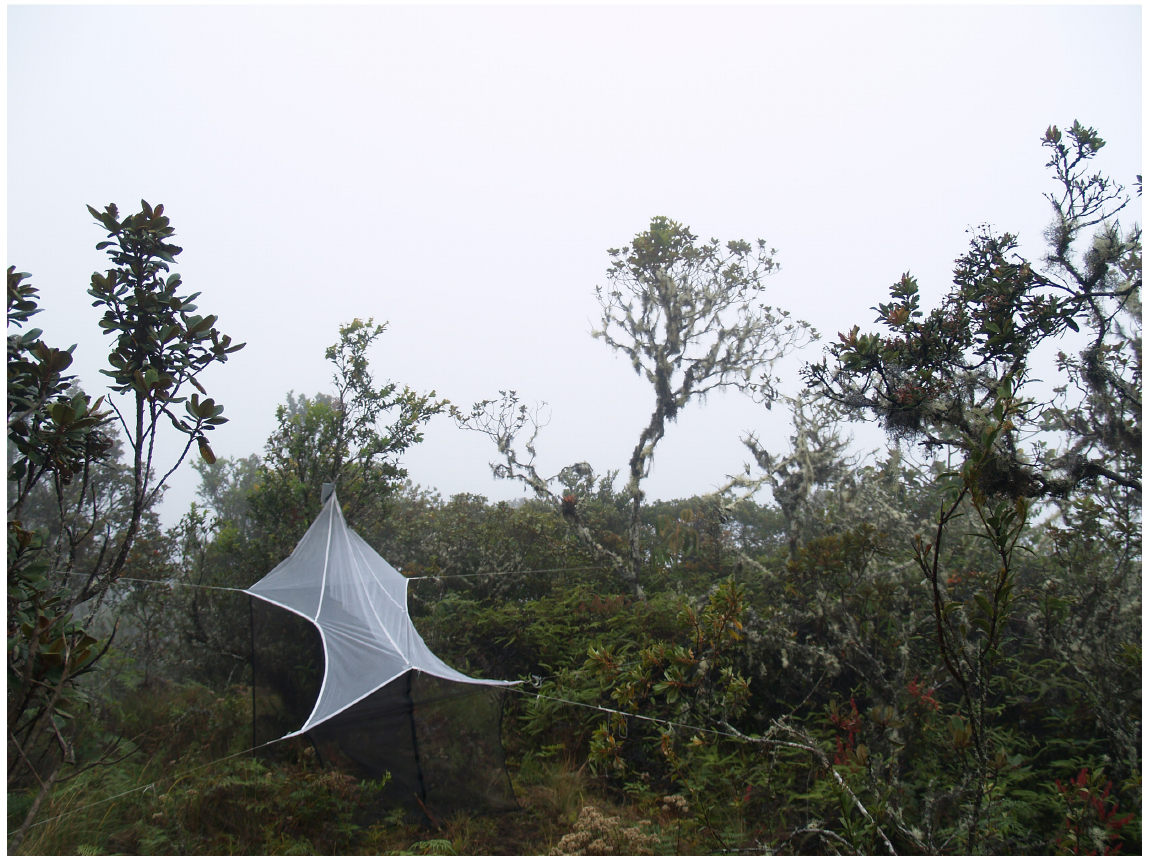
Fig. 1. Image of the pre-montane forest habitat in which Exetastes andensis sp. nov. was